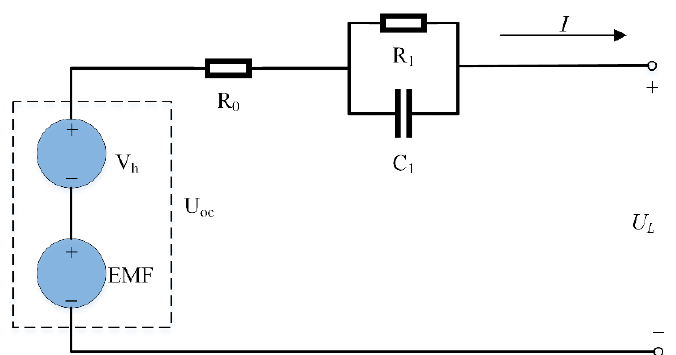
Figure 1. The schematic diagram of the one-state hysteresis equivalent circuit model (ECM). The hysteresis effect between the charge and discharge boundary curves is illustrated in Figure